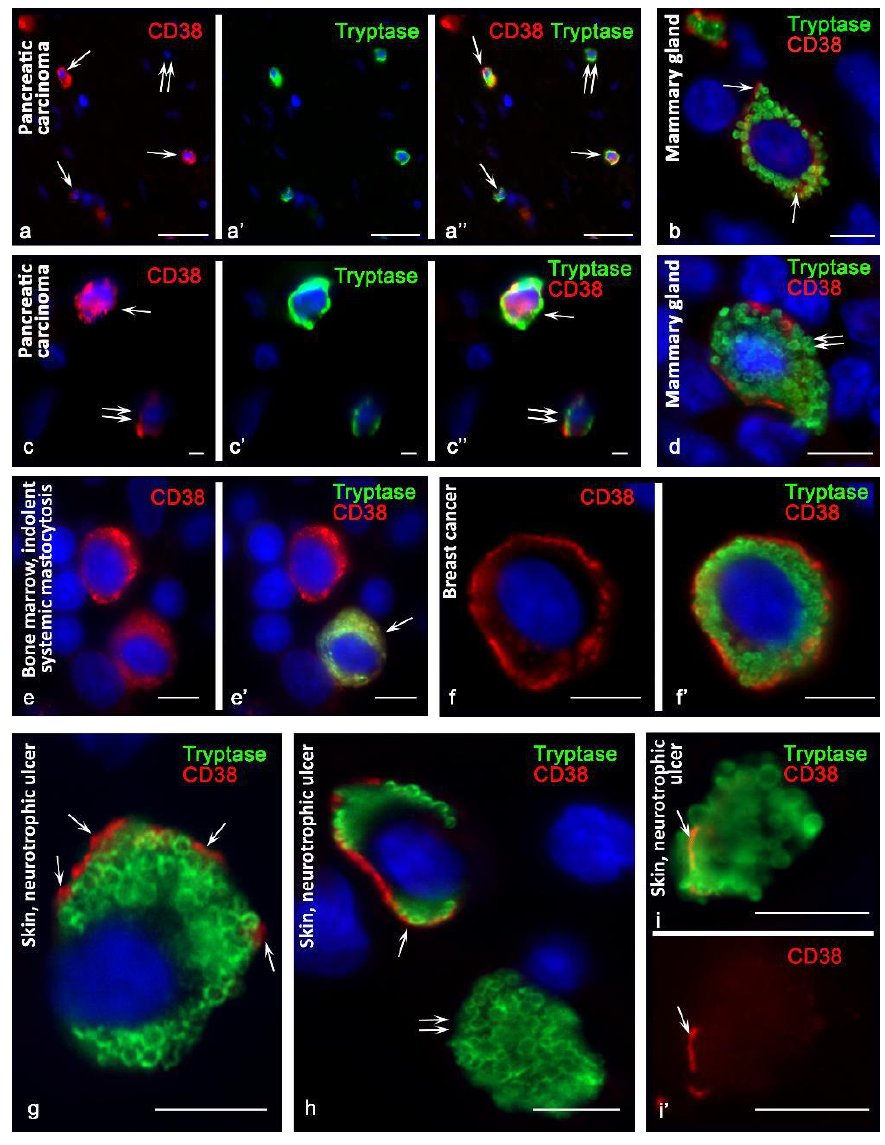
Figure 1. CD38 cytotopography in mast cells. Primary antibodies used: ( a – e ) rabbit monoclonal (Cell Marque, USA); ( f – i ) mouse monoclonal (kindly provided by Fabio Malavasi, University of Torino, Italy). ( a – a″ ) Pancreatic carcinoma. Cells with expression (arrowed) and without expression (double arrow) of CD38 are identified. ( b ) The mammary gland. Expression of CD38 in the cytoplasm and on the plasma membrane (indicated by an arrow). ( c – c” ) Pancreatic carcinoma. MCs with high (arrow) and moderate (double arrow) CD38 expression. ( d ) The mammary gland. The predominantly peripheral location of CD38 in the area of the plasma membrane, with varying severity along its length. At the site of secretion of tryptase, CD38 is absent (double arrow). ( e , e (cid:48) ) Indolent systemic mastocytosis, bone marrow. Diffuse distribution of CD38 in the cytoplasm of a hypogranulated mast cell (indicated by an arrow). ( f , f (cid:48) ) Breast cancer. Preferential peripheral location of CD38. ( g ) Skin. Peripheral localization of CD38 at some loci of the plasma membrane (indicated by an arrow). ( h , i , i (cid:48) ) Skin, neurotrophic ulcer. ( h ) MCs with CD38 expression on plasmalemma (arrowed) and absent (double arrow). ( i , i (cid:48) ) Expression of the exoenzyme at the peripheral locus of the non- nuclear cytoplasmic fragment of the mast cell (indicated by the arrow). Scale bar: 50 µ m ( a – a” ), 5 µ m (all